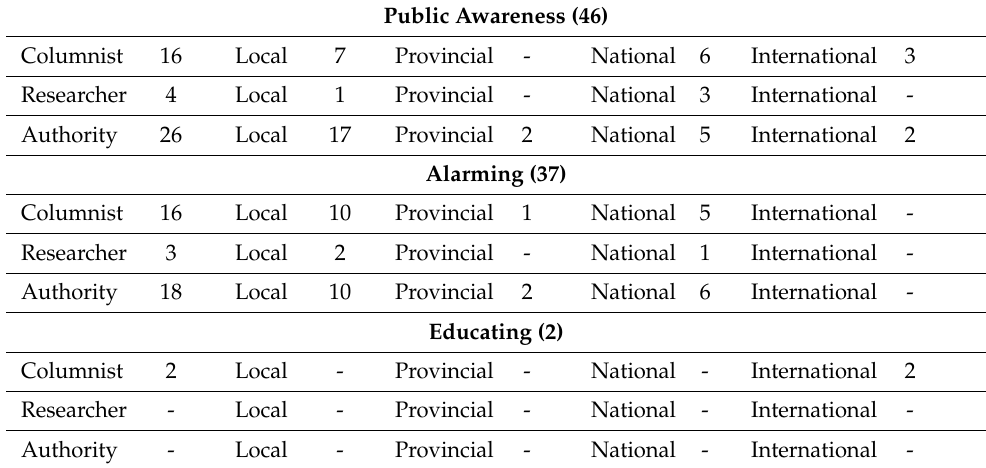
Table 5. Overall findings of water news in IRAN and Hamshahri newspapers (n=85 items).